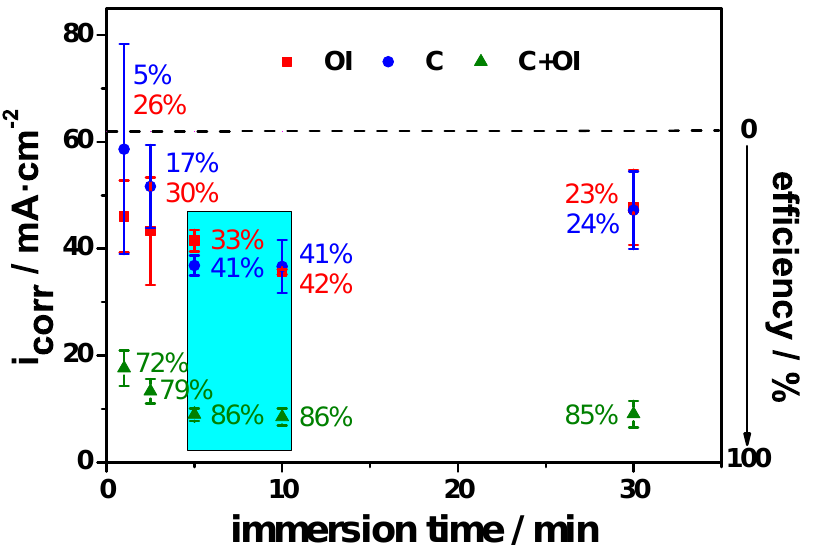
Figure 6. Effects of IE for increasing immersion time for compound C (red squares), OI (blue circles), and combination C + OI (green triangles up) each 50 mmol/L evaluated by